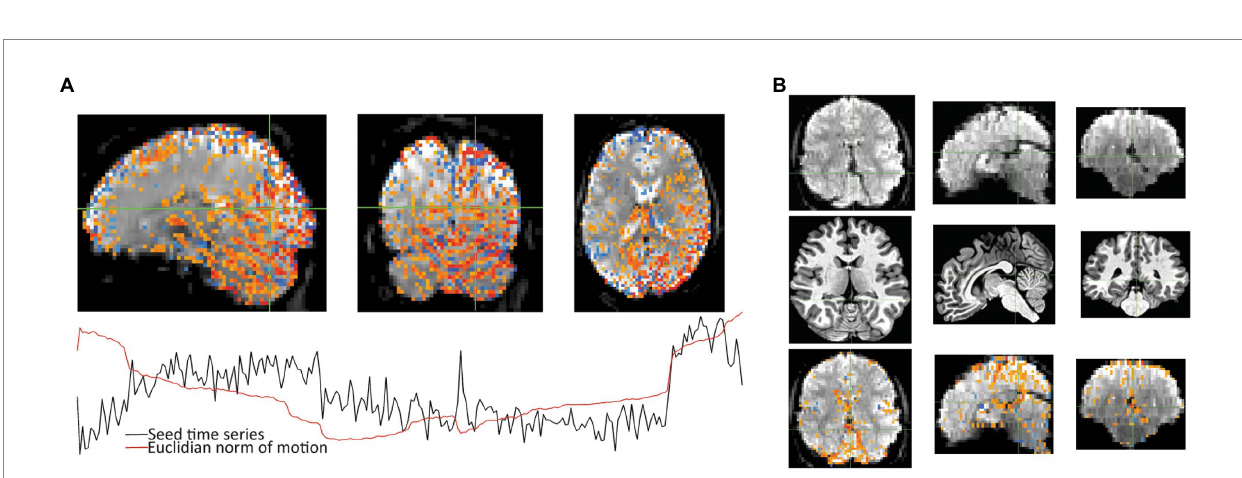
FIGURE 5 After seeing warnings due to “extent of local correlation” and “EPI variance lines” in AFNI’s automatic QC, instacorr was used to examine more closely. (A) For the correlation seed at the crosshair, Sub-018, shows an artifactual pattern of correlations ( p < 0.001) across large portions of the posterior cortex and cerebellum. Time series shows that some of this follows several large jumps in motion. (B) For Sub-002, an unusually large hypointensity was noticed in the unprocessed EPI that was alarming during the initial review. Anatomical viewing of the same slices shows a slightly large superior cistern and 4th ventricle. Correlations to the cross hairs on the unpressed image ( p < 0.001 with translucency below threshold) shows slightly larger correlations to CSF in the interhemispheric fissure. This observation will likely not cause problems for univariate statistical tests, but it could cause analysis issues if ROIs include this larger area of CSF that contains some internal